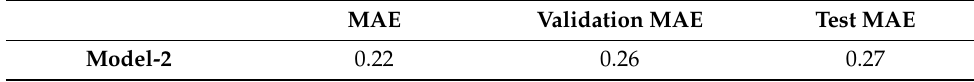
Table 4. Mean absolute error of